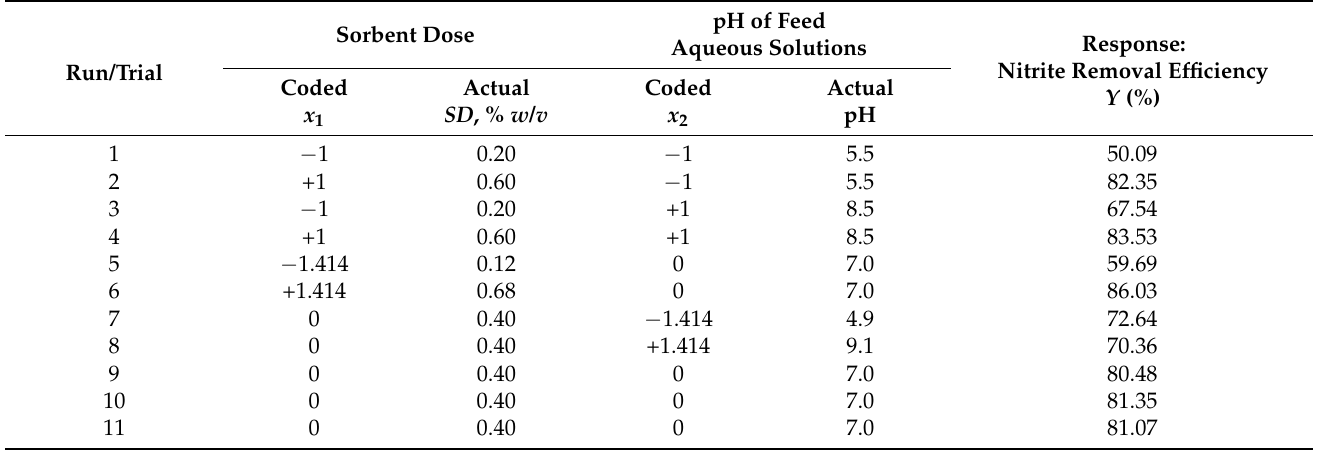
Table 1. Central composite experimental design of rotatable type employed for exploring the adsorption-ultrafiltration hybrid process for nitrite removal from aqueous solutions; fixed